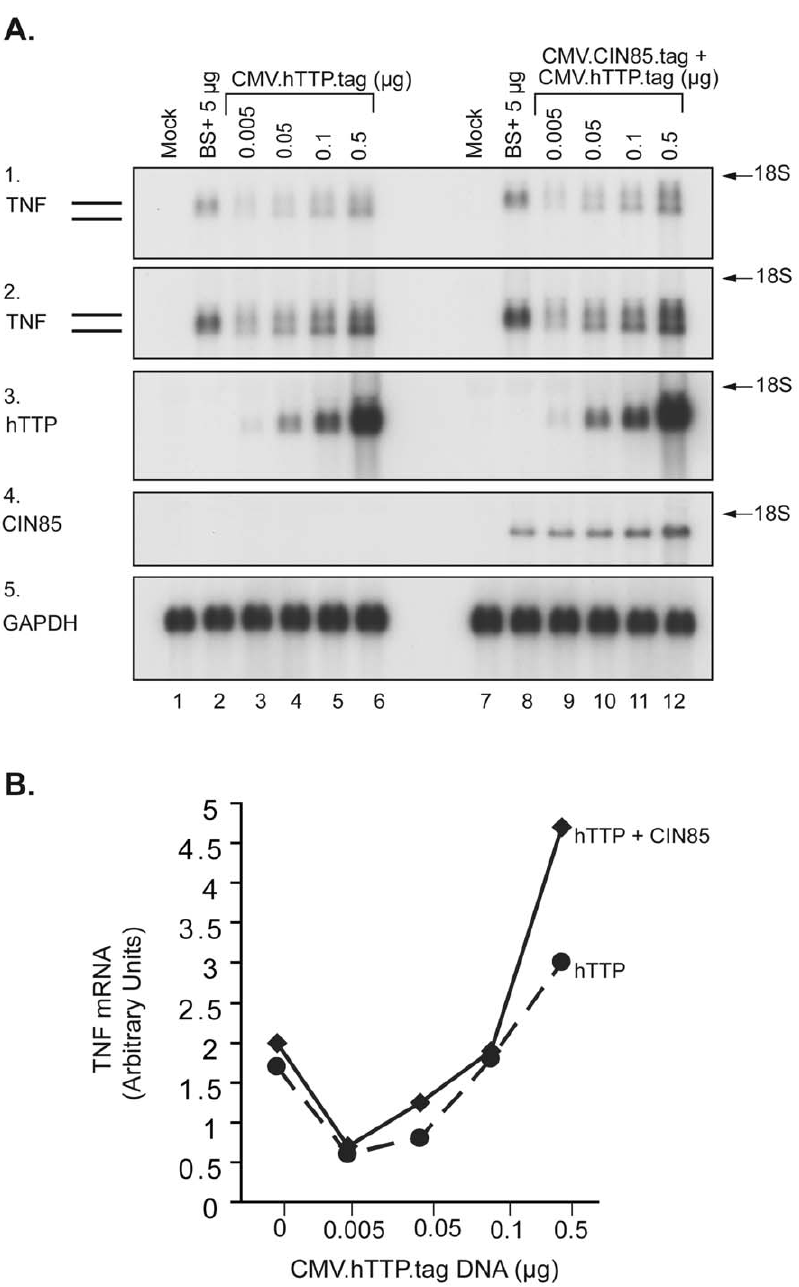
Figure 9. Effects of co-expression of CIN85 on hTTP-promoted destabilization of a TNF mRNA. In A, a CMV-driven mouse TNF-encoding plasmid was co-transfected into HEK 293 cells (lanes 2–6, 8–12) with either vector alone or with the indicated amounts of an hTTP expression construct in the presence or absence of 2 m g of a CIN85 expression construct. Total cellular RNA was harvested 24 h later, and used for northern blotting. Each lane was loaded with 10 m g of total RNA. Lanes 1 and 7 were from mock-transfected HEK 293 cells. Lanes 2 and 8 were from cells transfected with vector alone (BS + ; 5 m g/plate). Lanes 3–6, were from cells co-transfected with CMV.mTNF (1 m g) and CMV.hTTP.tag (0.005, 0.05, 0.1, and 0.5 m g/plate, respectively). Lanes 9–12 were from cells co-transfected with CMV.mTNF (1 m g) and CMV.CIN85.tag (2 m g) and CMV.hTTP.tag (0.005, 0.05, 0.1 and 0.5 m g/plate, respectively). Vector was also added as needed to make the total amount of co-transfected plasmids 5 m g/plate in each case. As indicated, the northern blots were probed with either a 32 P-labeled mTNF cDNA probe (panels 1 and 2, duplicate experiments), an hTTP probe (panel 3), a CIN85 probe (panel 4) or a GAPDH probe (panel 5). Film exposure was 4 h and 7 h, respectively, for panels, A1 and A2 for filters hybridized with an mTNF probe. All other filters were exposed to films for 7 h. The two parallel lines labeled TNF indicate the two species of TNF mRNA discussed in the text. The positions of the 18S rRNA are indicated. In B are shown the phosphorimager values for both species of TNF mRNA as a function of various TTP plasmid amounts, transfected with or without the CIN85 vector. The graph in B is from a single experiment, but is representative of three similar experiments.